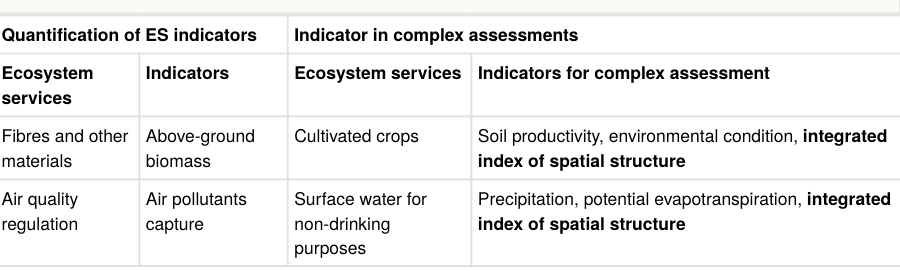
Application of the index in ecosystem services